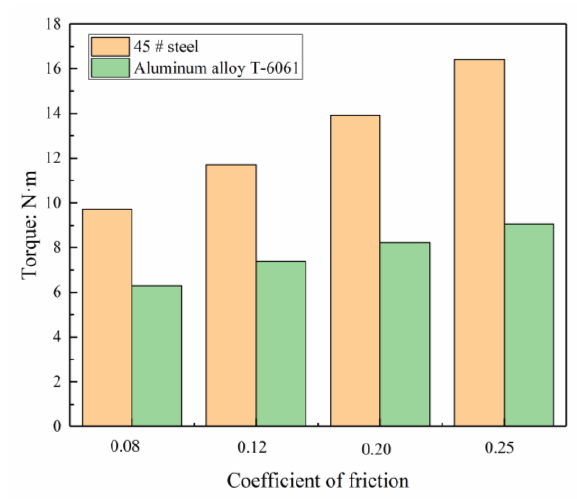
Figure 7. The influence of cooling lubrication on torque.